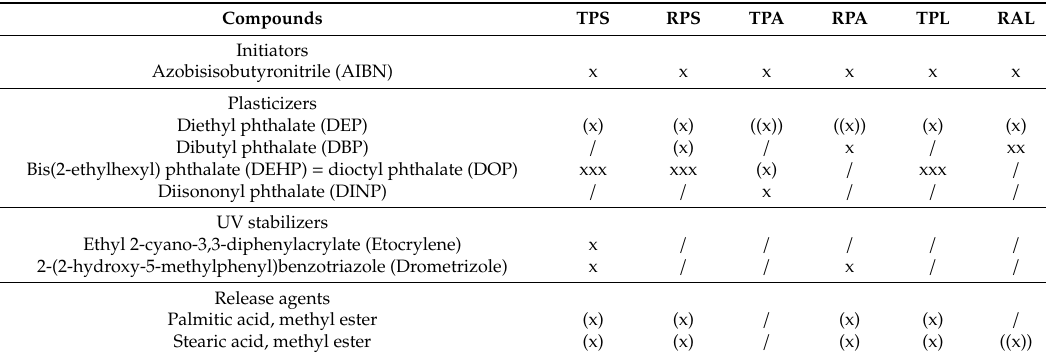
Table 4. Summary of additives identified by TD-GC / MS in the PMMA samples. For the abundance calculation: Peak area MMA / peak area 1 < 5: xxx; 5–15: xx; 15–100: x; > 100: (x) (peak area 1 = peak area of the compound of interest).